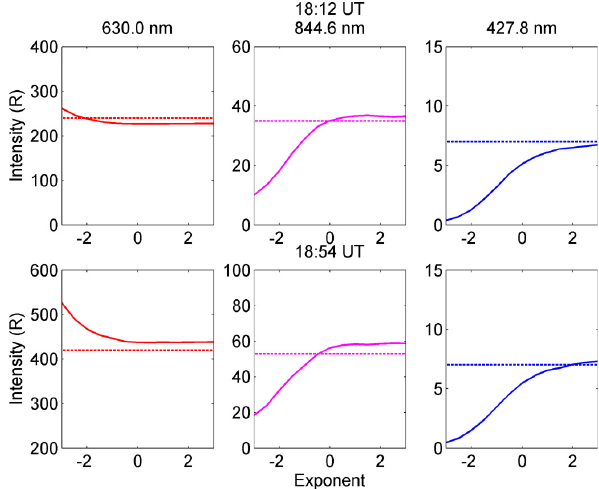
Fig. 10. . Emission intensity dependence on the exponent of the power-law energy spectrum of the electron acceleration source. The top row corresponds to the heating pulse at 18:12UT. The bottom row corresponds to the heating pulse at 18:54UT. The solid lines show the calculated emission intensities. The dashed lines indicate the values of the emission intensities observed in the experiment. ≡ I exp I mod 6300 6300